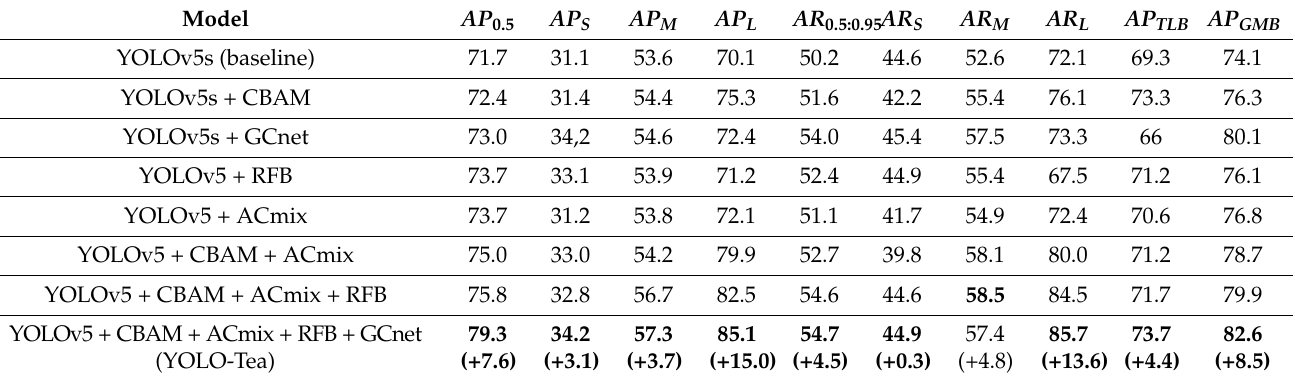
Table 5. The data from the ablation experiments.